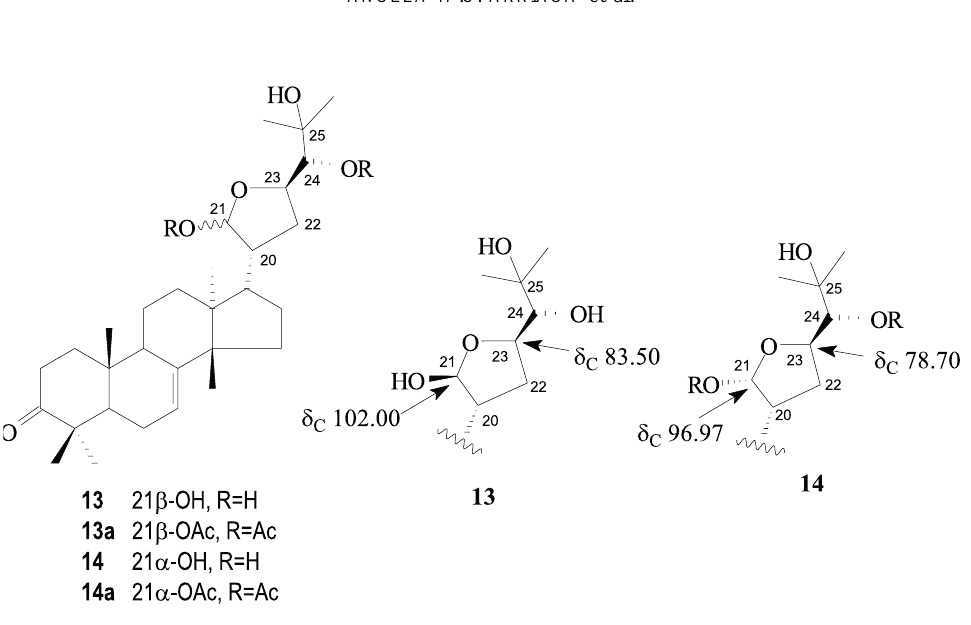
Fig. 5 – Comparison of the 13 C chemical shifts of atoms CH-21 and CH-23 of 13 and 14 and deduction of the relative